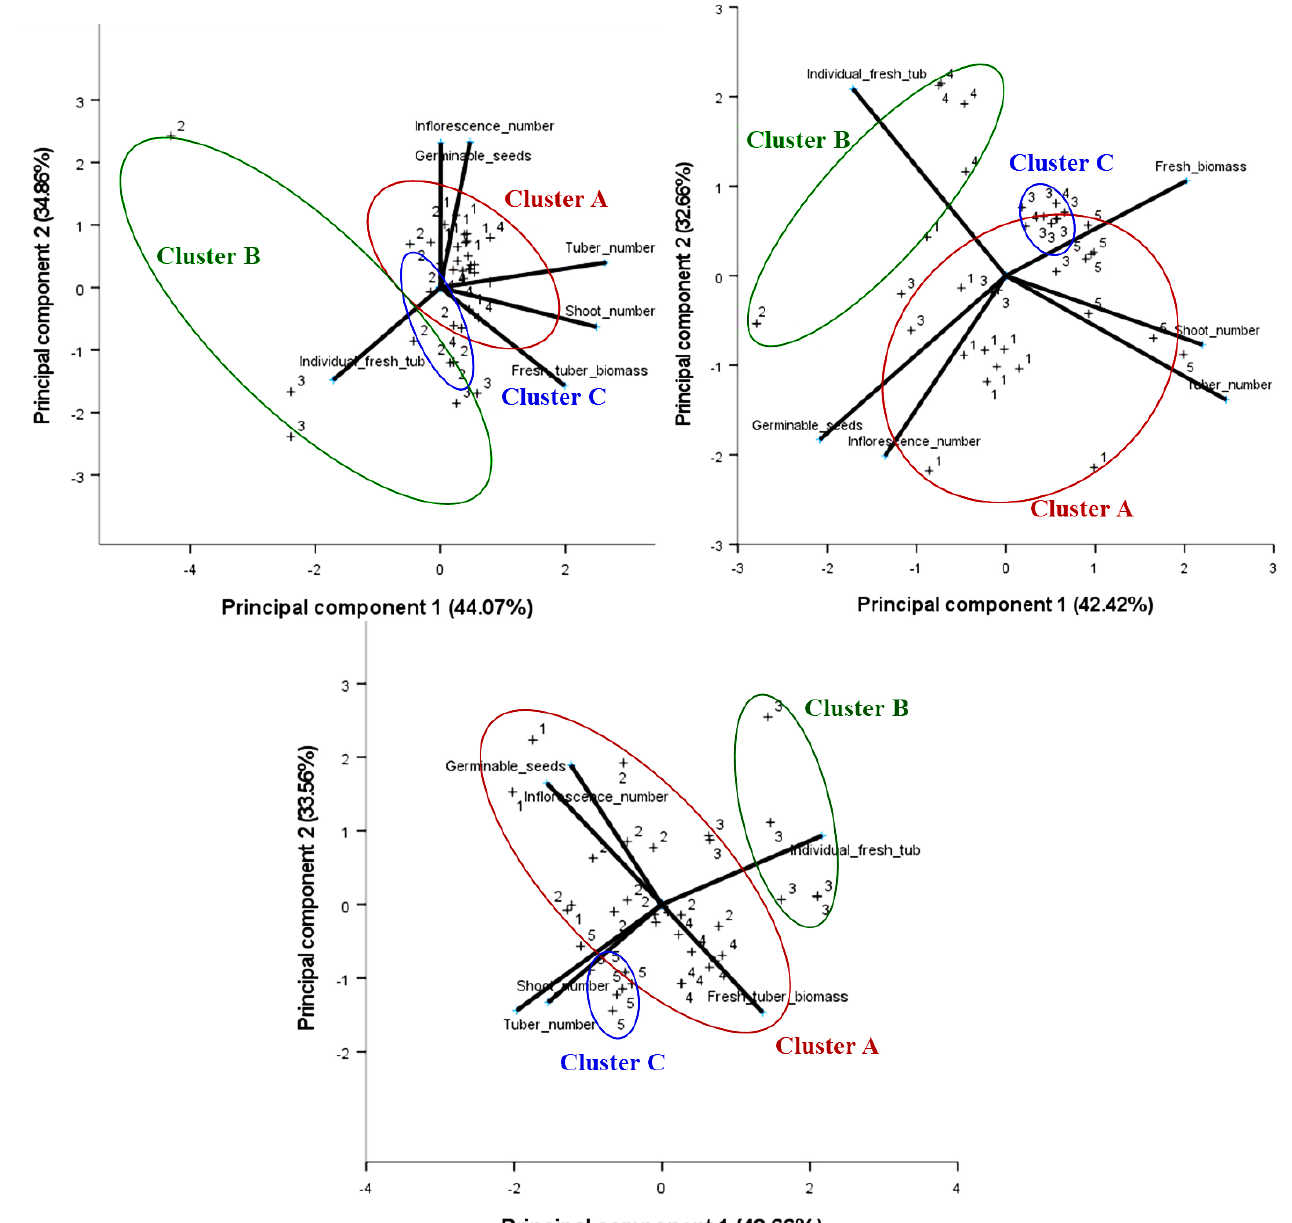
Figure 6. Three biplots (one for each experimental year, top left: 2018, top right: 2019, and bottom: 2020) of 35 C. esculentus clonal populations along the first and second principal component axis resulting from categorical principal component analysis on the morphological data. Signs are labelled by morphological cluster (see Figure 5). The three genetic clusters A, B, and C are indicated by red, green, and blue circles, respectively.